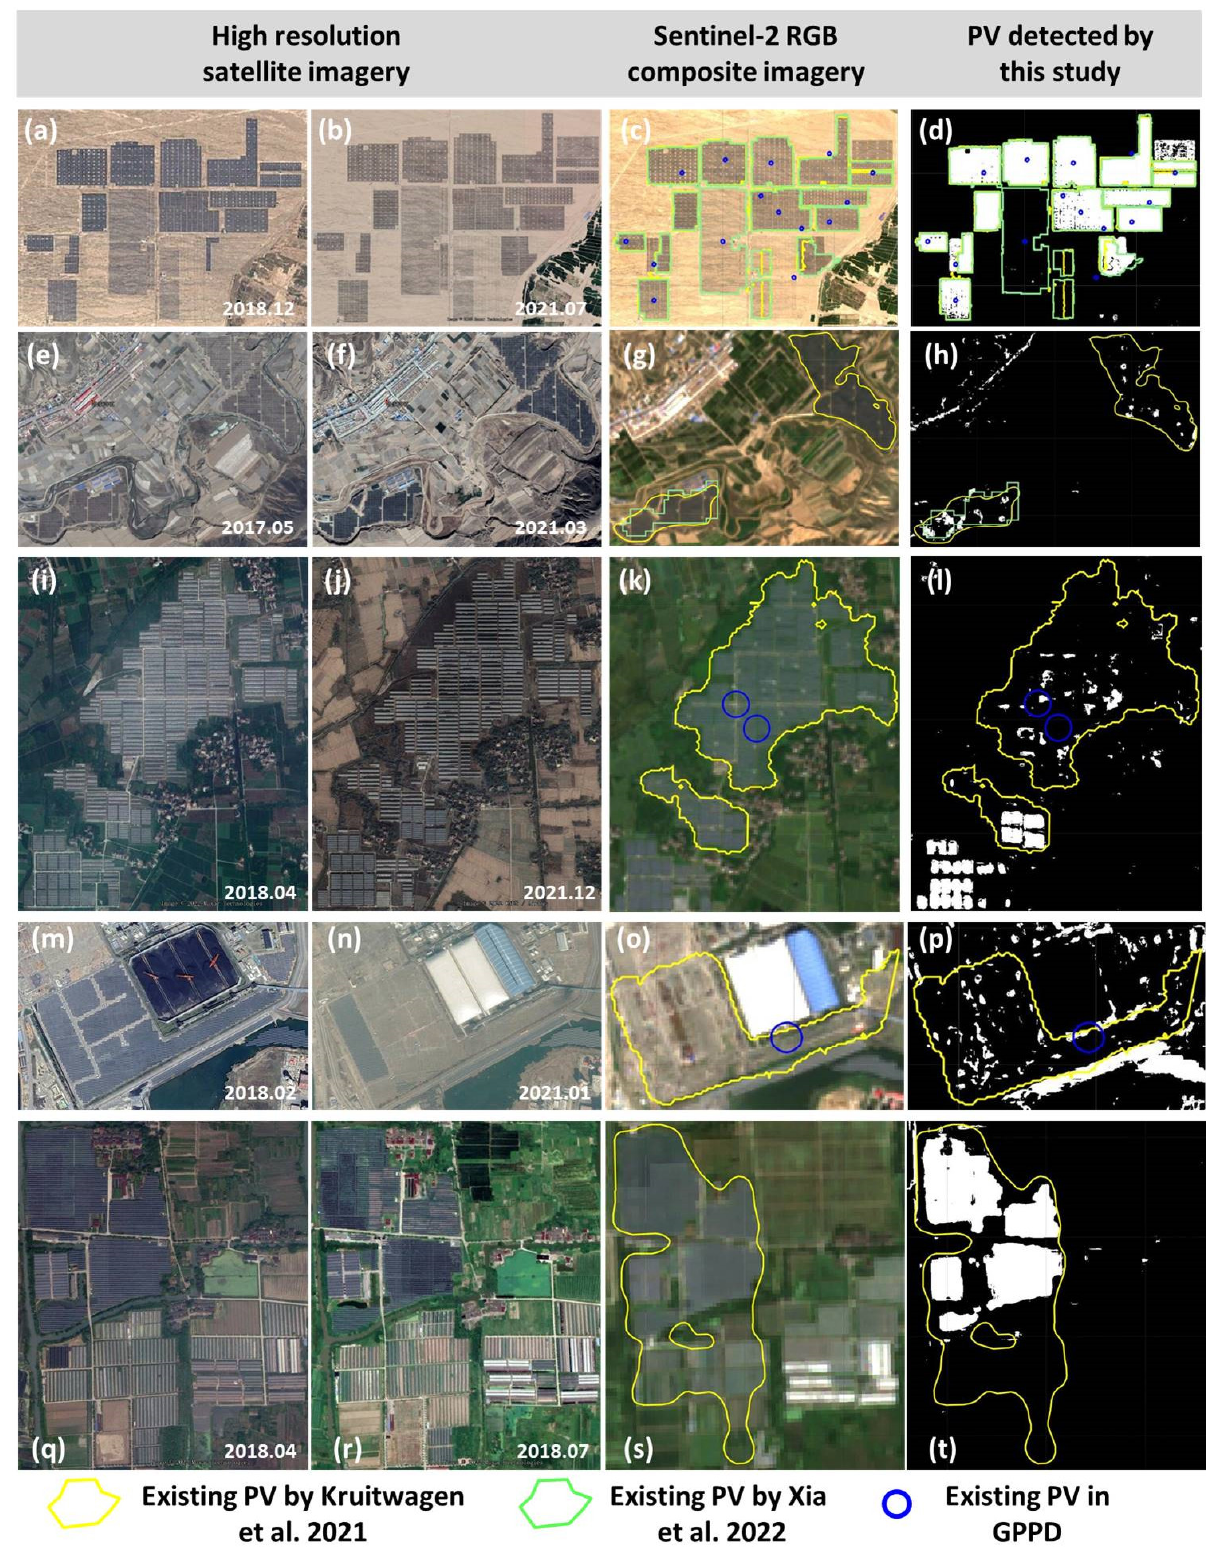
Figure 10. Undetected PV compared to existing PV database ( a – d ) 102.13°E, 38.60°N; ( e – h ) 104.58°E, 35.84°N; ( i – l ) 119.85°E, 30.95°N; ( m – p ) 121.09°E, 28.16°N; ( q – t ) 120.43°E, 30.71°N [12,15]. The final spatial distributions of PV extracted in Gansu Province and Zhejiang Province are shown in Figure 11. It is worth noting that there are still wrongly detected